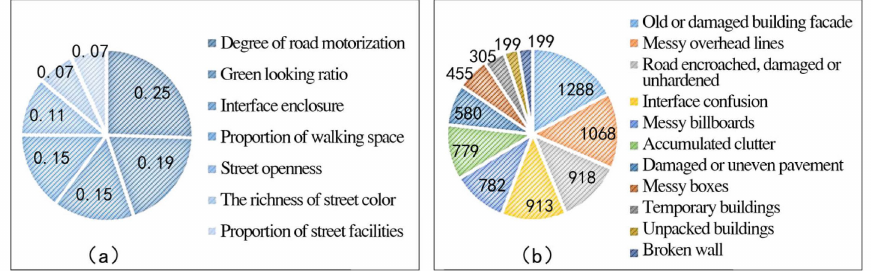
Figure 18. Importance score of the feature elements of branch roads ( a ) and audit situation of street spatial quality issues ( b